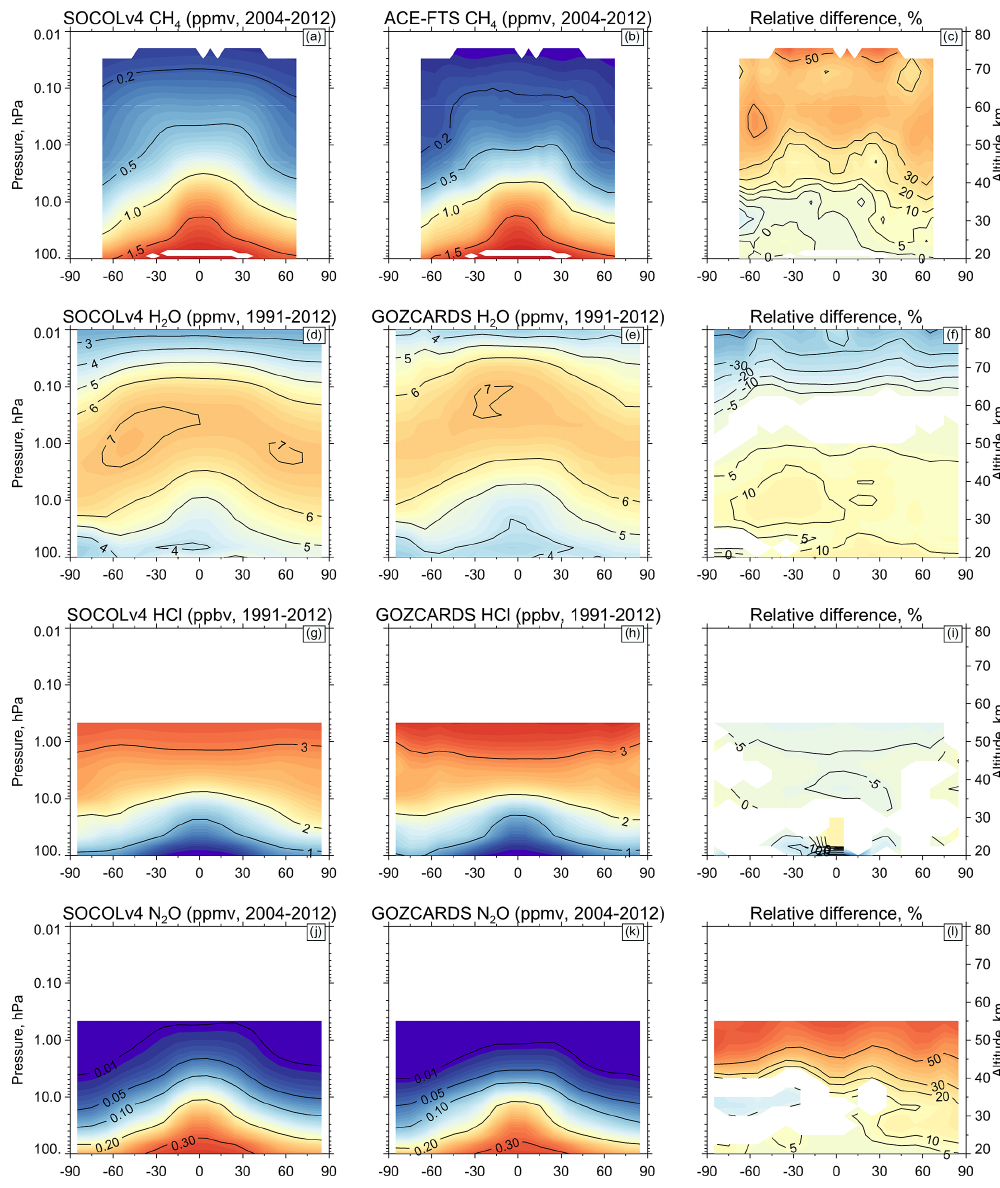
Figure 8. Annually averaged zonal mean distributions of CH 4 , H 2 O, HCl, and N 2 O (from top to bottom). First column: SOCOLv4 data. Second column: ACE-FTS and GOZCARDS observational data. Third column: relative difference between the model and observations in %. An observational missing data mask is applied to the modeling results. Note that different species have different averaging periods. White areas are either the missing data or regions where the difference between model and observations is not statistically significant at the 95% confidence